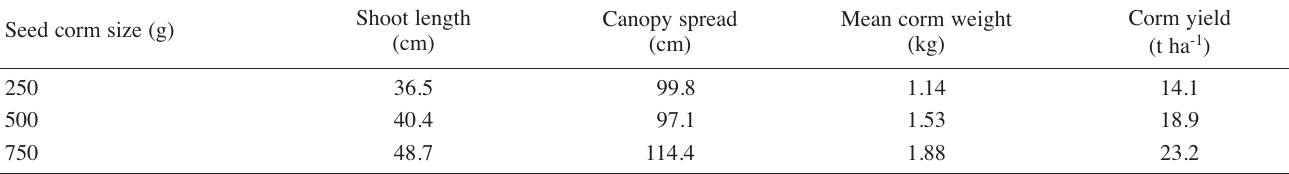
Source: James and Nair,